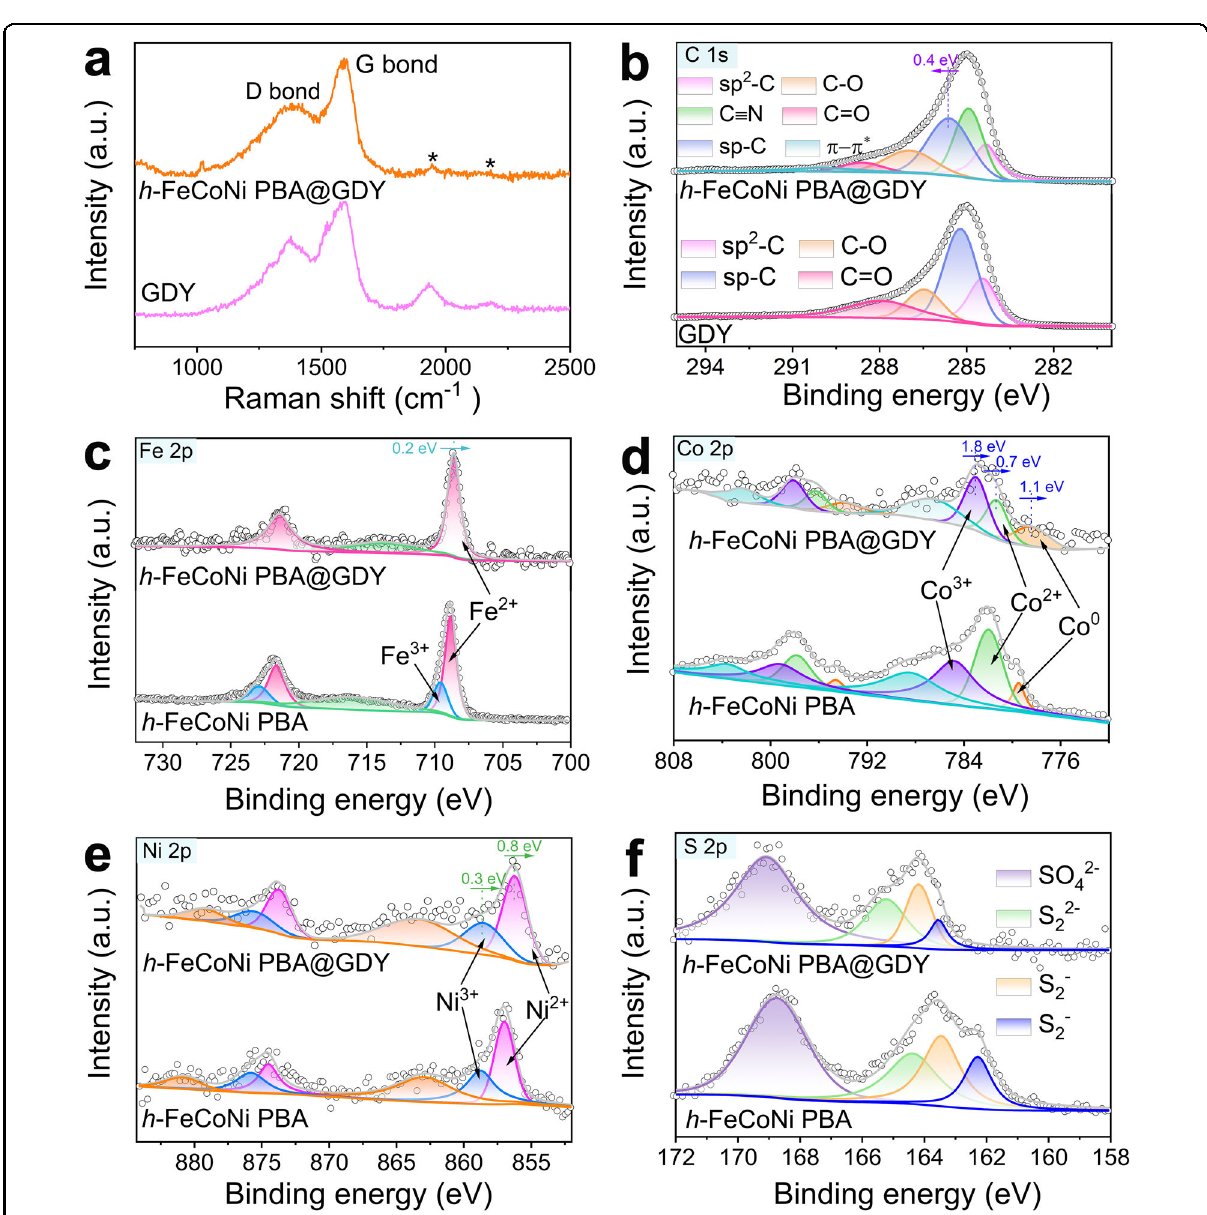
Fig. 4 Structural characterization. a Raman spectra of h -FeCoNi PBA@GDY and GDY. b C 1s XPS spectra of h -FeCoNi PBA@GDY and GDY. c Fe 2p, d Co 2p, e Ni 2p and f S 2p XPS spectra of h -FeCoNi PBA@GDY and h -FeCoNi